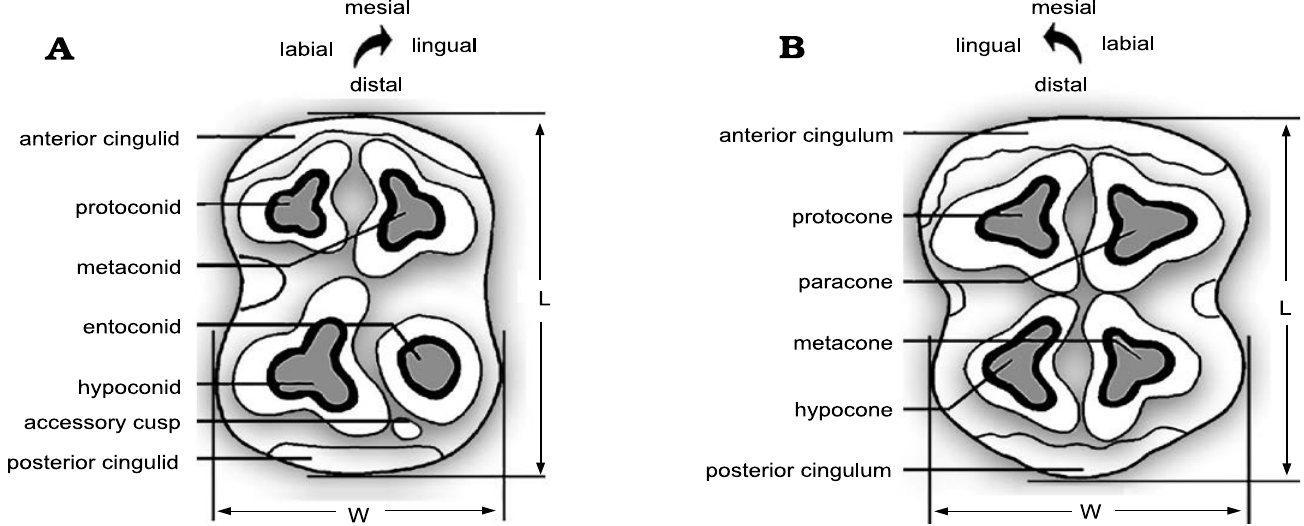
Fig. 2. Hippopotamid cheek teeth nomenclature based on the left m2 and M2 in occlusal view. Accessory cusps may be present or absent on upper and lower teeth. The m3 is characterized by a fifth distal cusp called hypocolunid. Modified from Htike